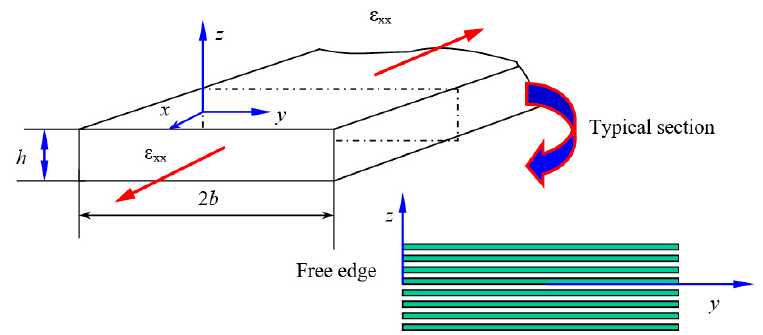
Figure A1. Geometry and coordinate system for a laminate free-edge problem.